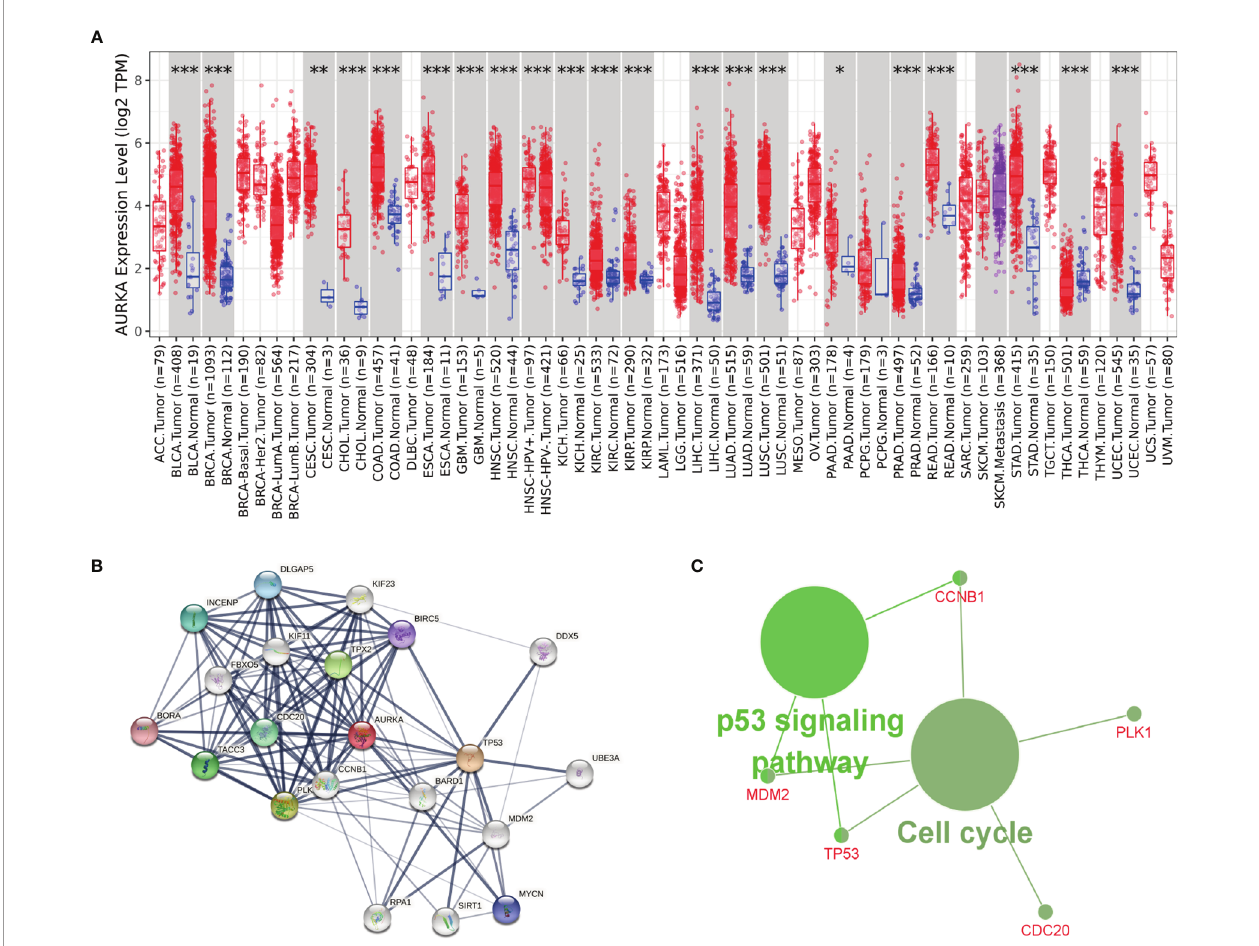
FIGURE 7 | AURKA ’ s biological involvement in tumors. (A) AURKA expression in different tumors. (B) AURKA gene STRING interaction network preview of interacting proteins (showing top 20 STRING interactants). (C) Illustration of KEGG pathway analysis fi ndings using the ClueGO plugin in Cytoscape. *P < 0.05, **P < 0.01, ***P < 0.001.